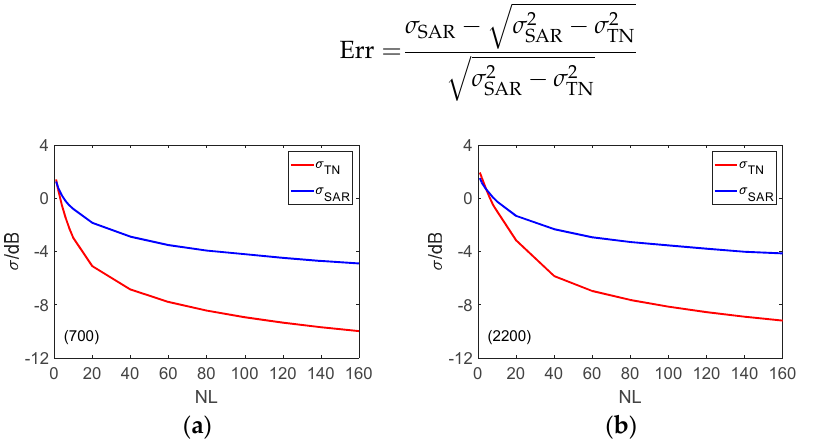
Figure 6. The variations in σ TN and σ SAR with the increasing in the NL : ( a ) column 700; ( b ) column 2200. Two columns of the interference phase were selected along the extension direction of interferogram, which were used to evaluate the relative errors with Equation (19) for different NL s, and the relative errors are given in Table 3. In order to maintain the relative error below 10% in the present work, we chose NL = 6 × 10 ( NL = 6 × 10 means that there phase noise suppression. Table 3. The relative error (%) of the interference phase caused by phase noise with different looknumbers in the 700th and 2200th columns,